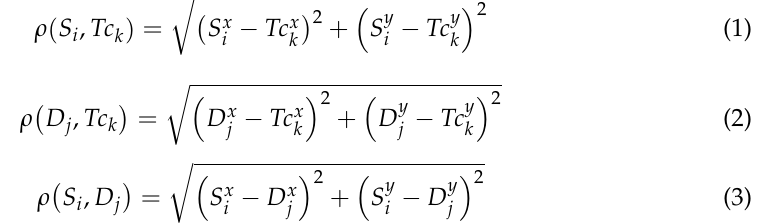
Figure 2. Horizontal motion of a tower crane. ( ) , , x y z Tc Tc Tc are the coordinates of the tower crane at position k , In the figure, k k are the coordinates of the trailer at position i , and